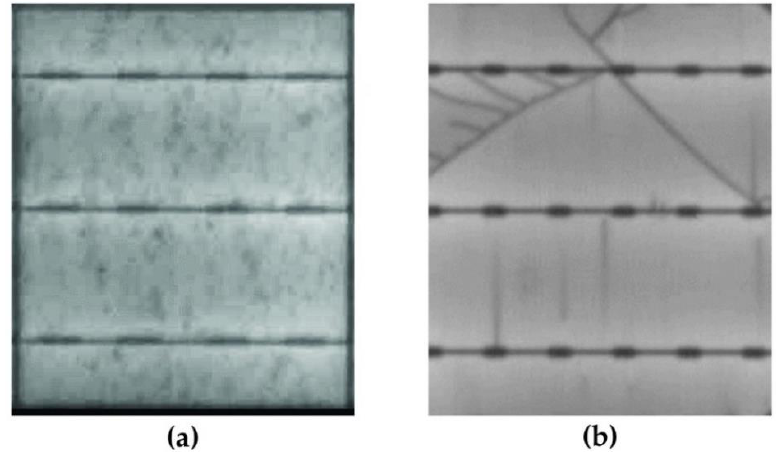
Figure 6. Typical grayscale EL images of a solar wafer. ( a ) degradation-free, ( b ) degraded